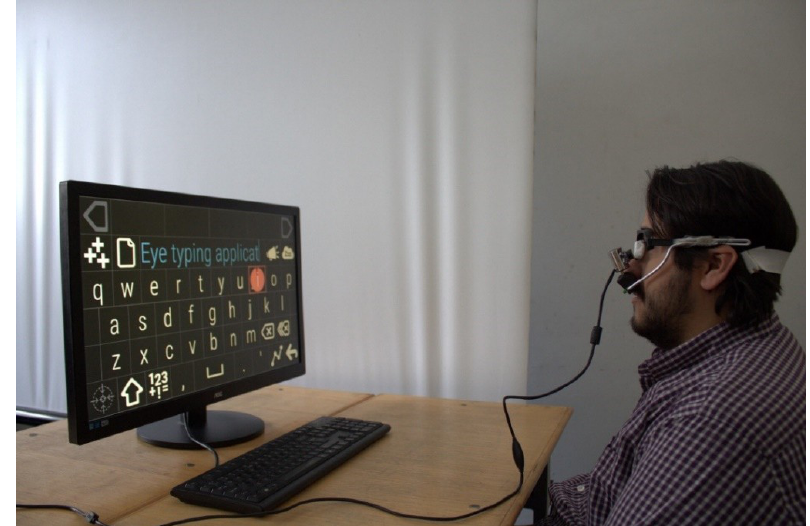
Figure 1. Head-mounted eye tracking interface.